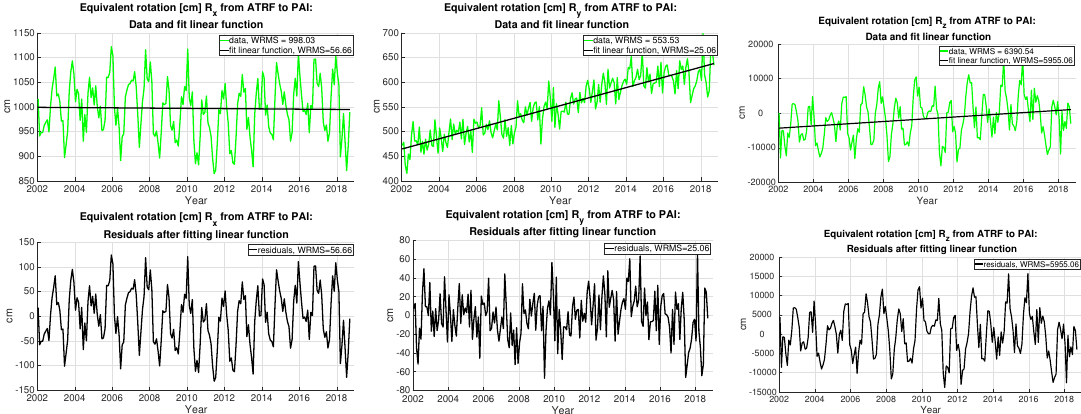
Figure 1. The results derived from the RL06 CSR Stokes coefficients with monthly resolution: ( top ) equivalent rotations [cm] R x , R y , and R z from ATRF to PAI frame (in green, from left to right) and fit linear functions (in black); and ( bottom ) the residuals are also given in